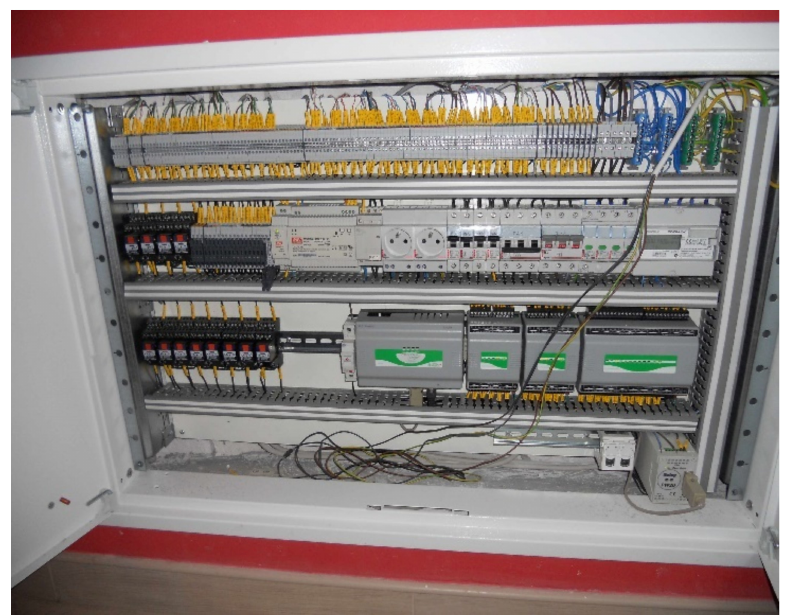
Figure 3. Measuring and recording control panel installed in the experimental house EB2020 [15,16].